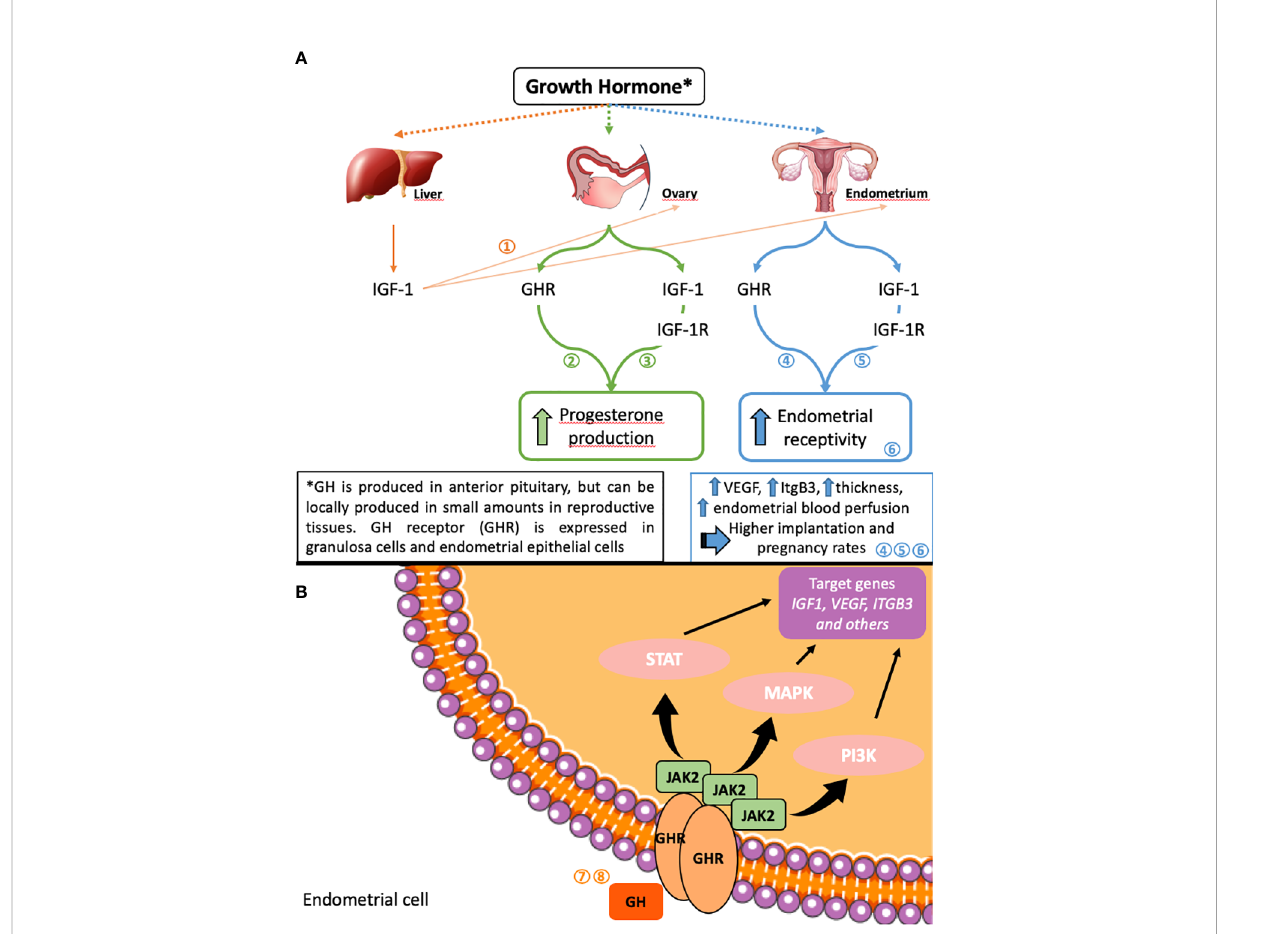
FIGURE 2 Possible mechanisms of GH effects on ovarian and endometrial function (A) and on endometrial cells (B) . Adapted from